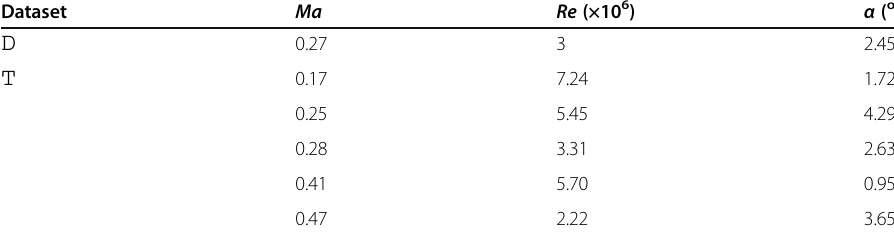
Table 1 The flow cases of dataset D and T used for feature selection